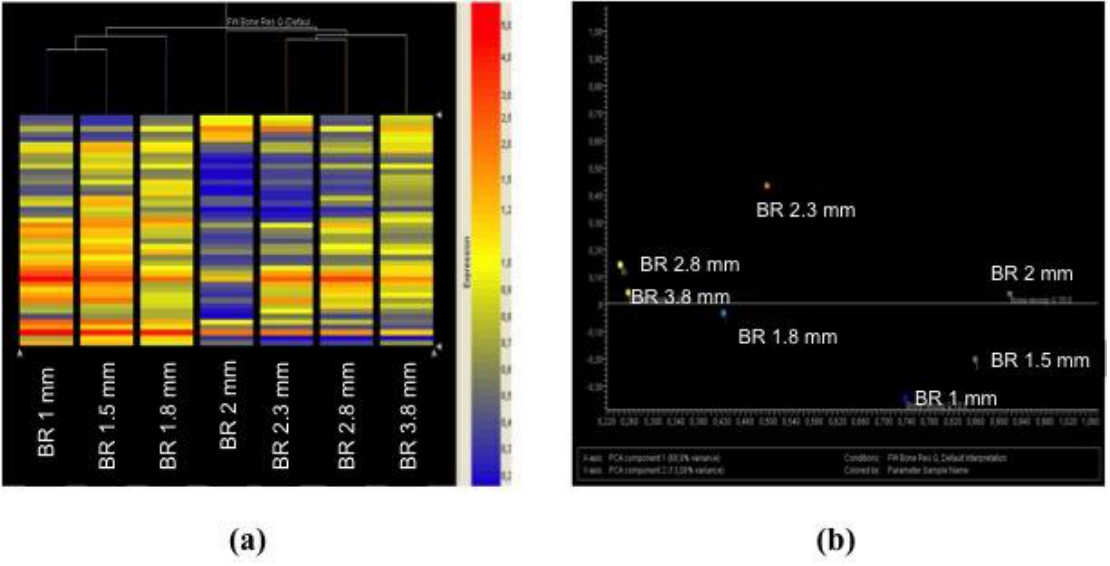
Figure 4. Hierarchical cluster ( a ) and principal component analysis of variance ( b ) analyses showing the occurrence of miRNA alteration in implants with BR > 2 mm.